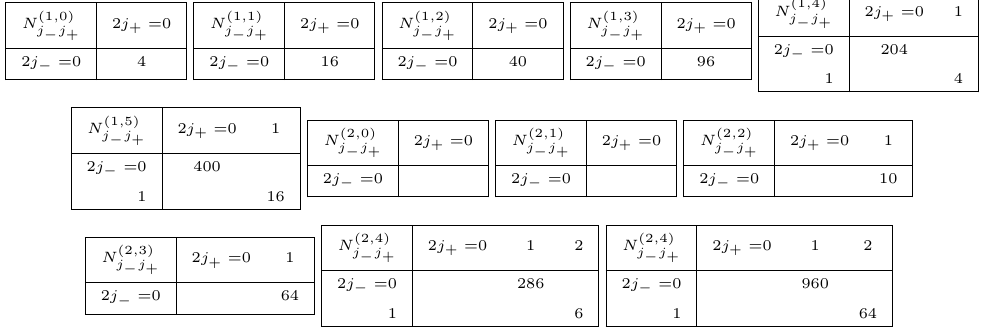
of M 0 , for base degree b (cid:20) 2 and (cid:12)ber degree d (cid:20) 5. 4 j (cid:0) ;j +